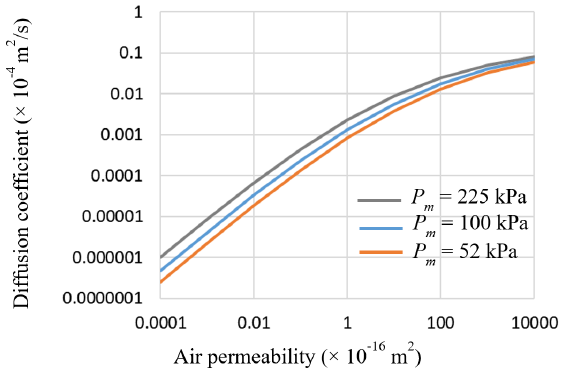
Figure 7. Relationship between the air diffusivity and permeability described by Eq. (15) with a = 0.25 and D 0 = 0.160 × 10 ‐ 4 m 2